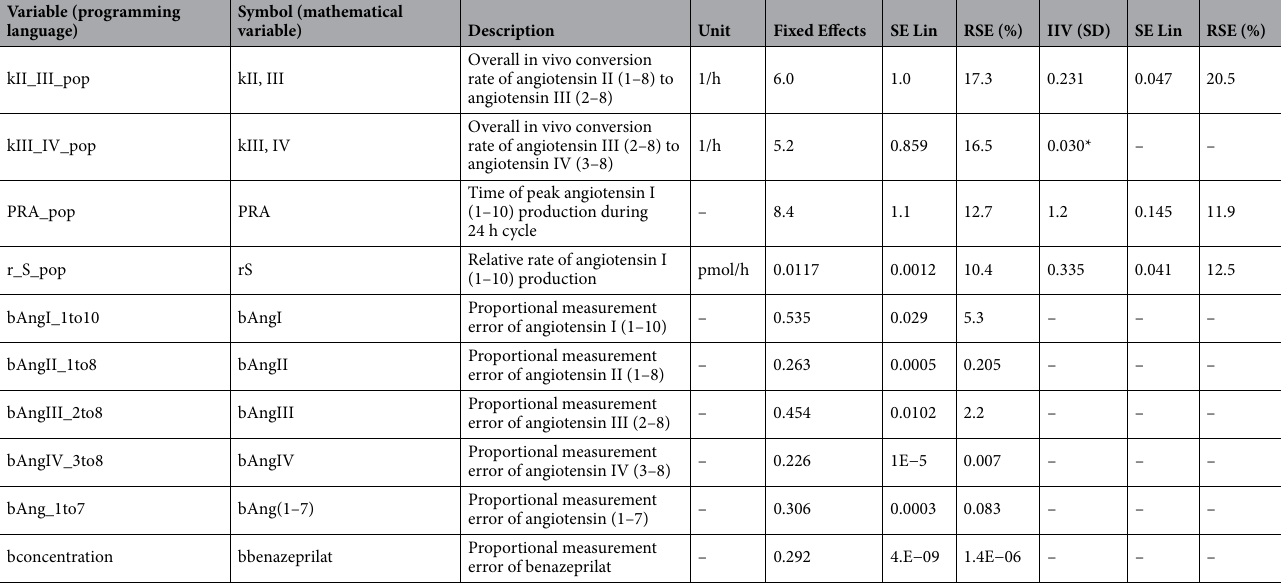
Table 1. Parameter estimates. The full table of parameter estimates. In the first column, the name of the parameter used in the computer code is given. Then, the variable name for the mathematical equations is given. A description of the parameter and units are given in the next two columns. Finally, the actual value of the estimate along with error estimate, gamma (standard deviation) estimate, and the error of the standard deviation estimate. Low residual error estimates on the table of parameters indicate that the model is not over- parameterized and the identification of parameters is precise. **: fixed typical value estimate; *: random effect fixed to an arbitrary small